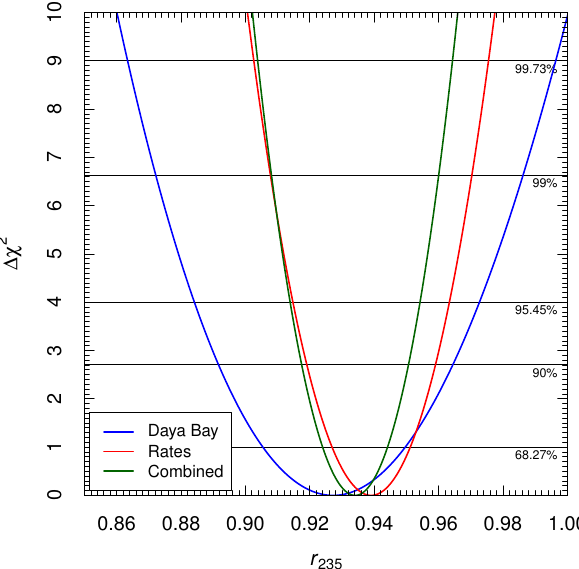
Figure 2 . Marginal (cid:1) (cid:31) 2 = (cid:31) 2 (cid:0) (cid:31) 2 for the factor r 235 obtained from the (cid:12)t of the Daya Bay min evolution data [11] (Daya Bay), from the (cid:12)t of the reactor rates (Rates), and from the combined (cid:12)t (Combined) with the 235